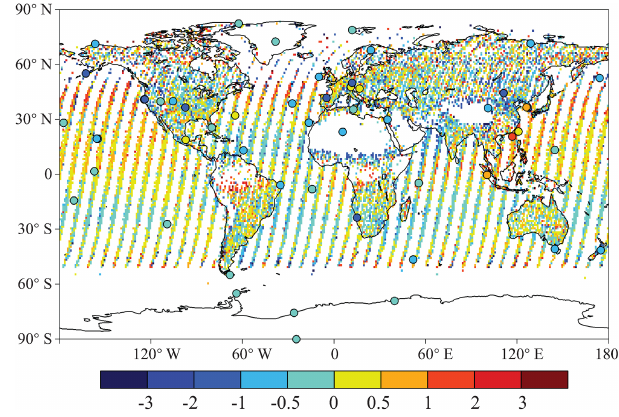
Figure 4. Distributions of the BIAS of the posterior (cycles) sur- face CO 2 and (shading) XCO 2 concentrations (simulations minus observations or